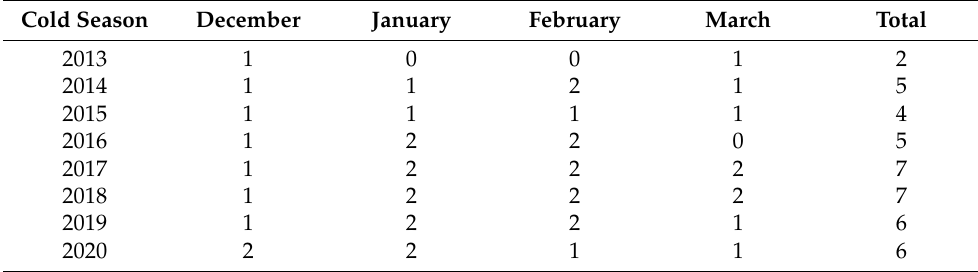
Table 1. The summary of Landsat OLI images used during the cold season from 2013 to 2020. Cold